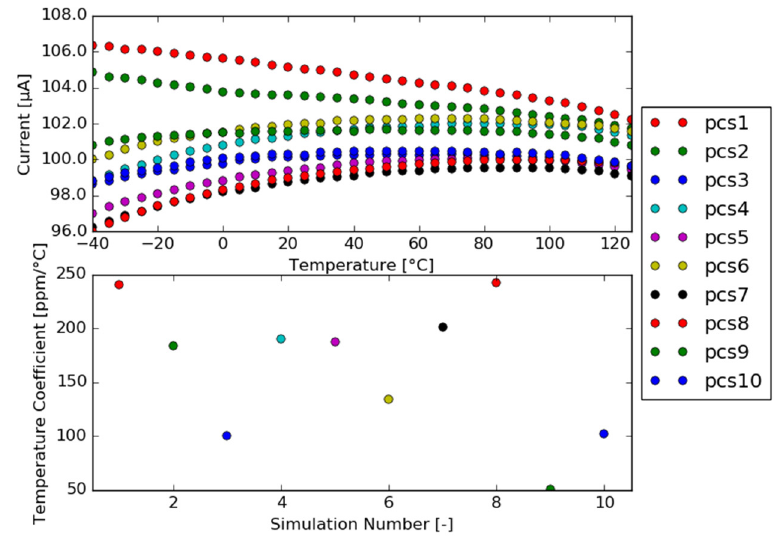
Figure 21. PCS output current against temperature. Table 5. Experimental temperature coefficients of PCS.